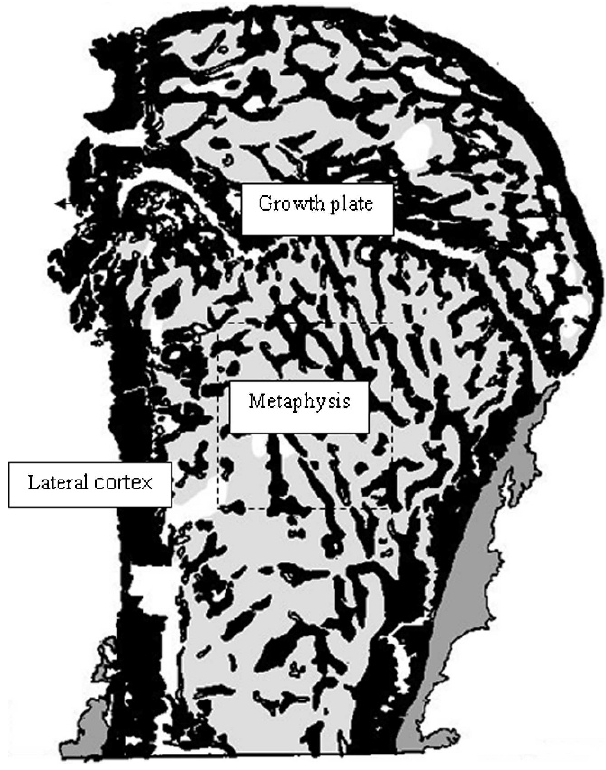
Figure 1 - Metaphyseal region of longitudinal section of distal femur. All histomorphometric parameter measurements were performed randomly at the metaphyseal region, which was located 3-7 mm from the lowest point of the growth plate and 1 mm from the lateral cortex, excluding the